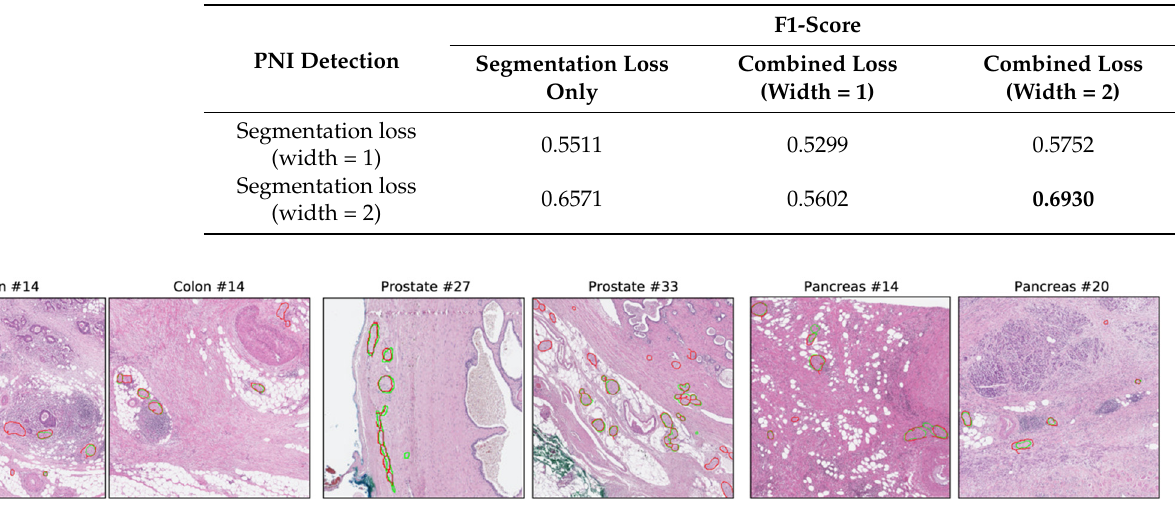
Figure 9. Examples of predicted nerve boundary. Table 2. Average F1-score on test sets for nerve detection.